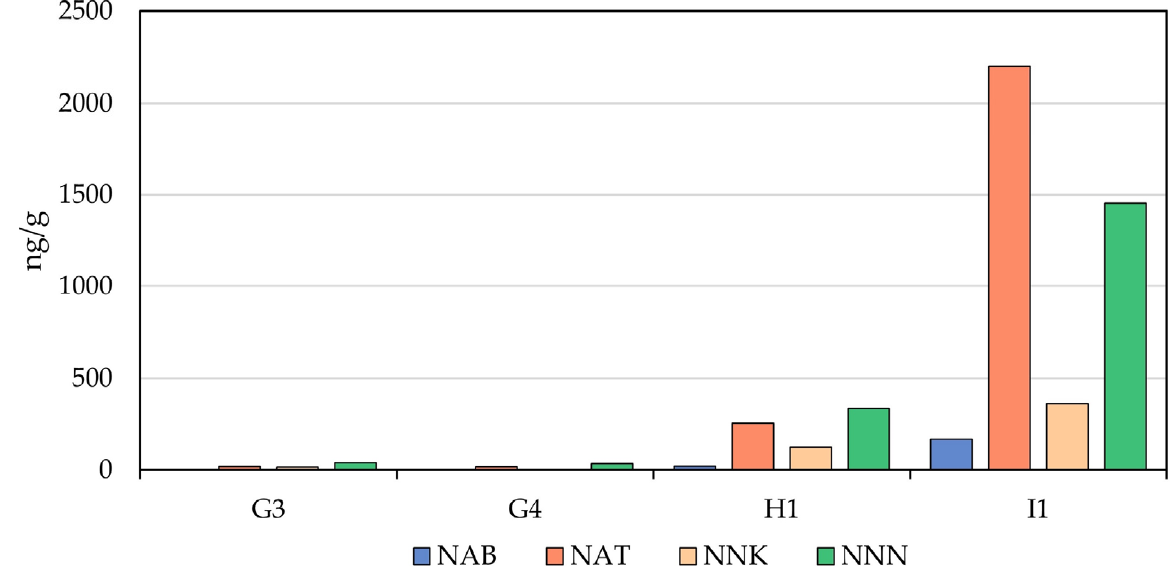
Figure 1. Comparison of the observed TSNA levels in the two long-cut Black Buffalo MONPs (G3 and G4) to the two commercial STPs (H1 and I1).